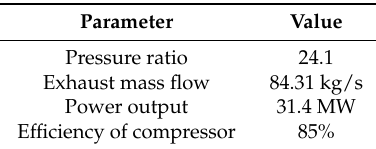
Table 1. Base load parameters of gas turbine.